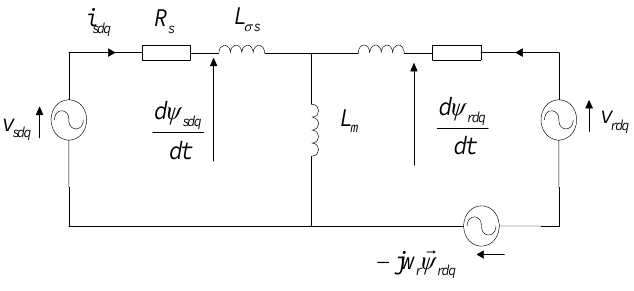
Figure 4. Equivalent circuit of doubly fed induction generator (DFIG) wind turbine.